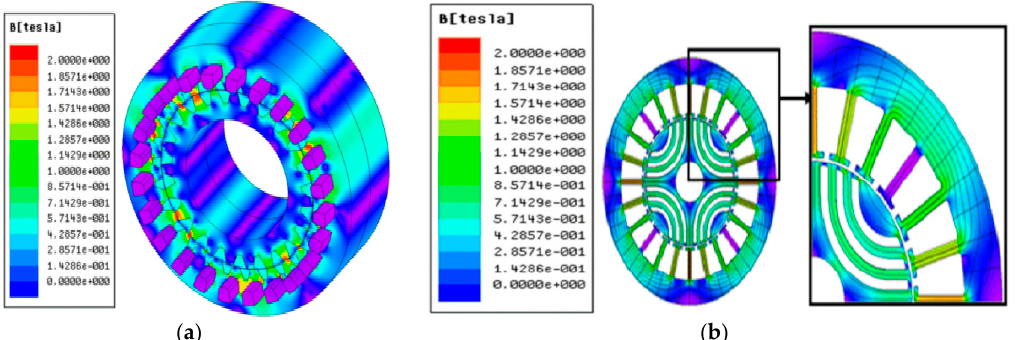
Figure 11. Magnetic flux with FEM analysis solutions after two-step optimization in genre 1 of six-phase synchronous reluctance motor: ( a ) full cross-section view of three-dimensional diagram at stator and windings; ( b ) full cross section and quarter cross section of two -dimensional diagram at stator and rotor.